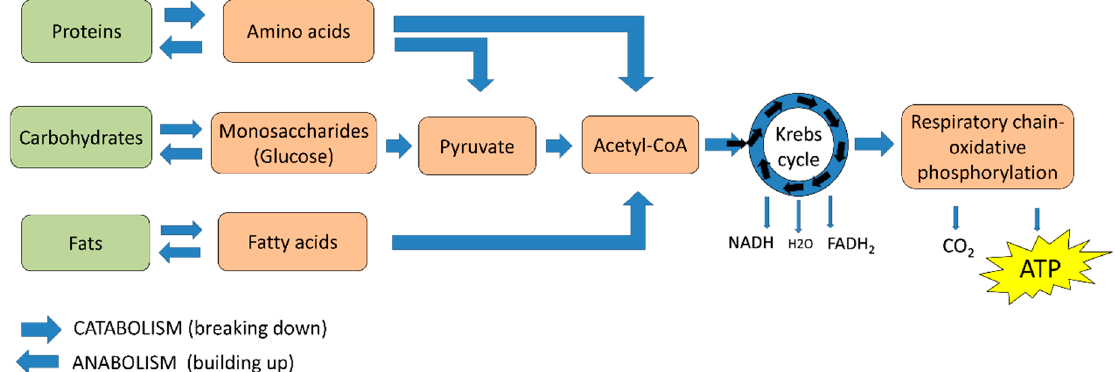
Figure 1. ATP production from food metabolism. Amino acids, monosaccharides, and fatty acids are produced from the metabolism of proteins, carbohydrates, and fats, respectively, from which pyruvate and/or acetyl-CoA are obtained, which, in turn, are generally metabolized in the Krebs cycle and the oxidative phosphorylation